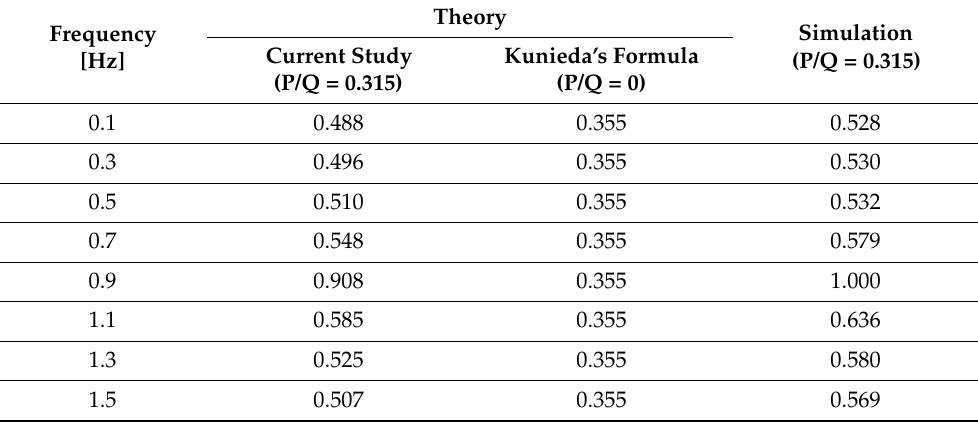
Figure 12. The comparison of the ratios of wheel unloading according to the frequencies of a cross-wind. Table 13. The comparison between the theoretical formulas (current study and Kunieda’s formula) and simulations.